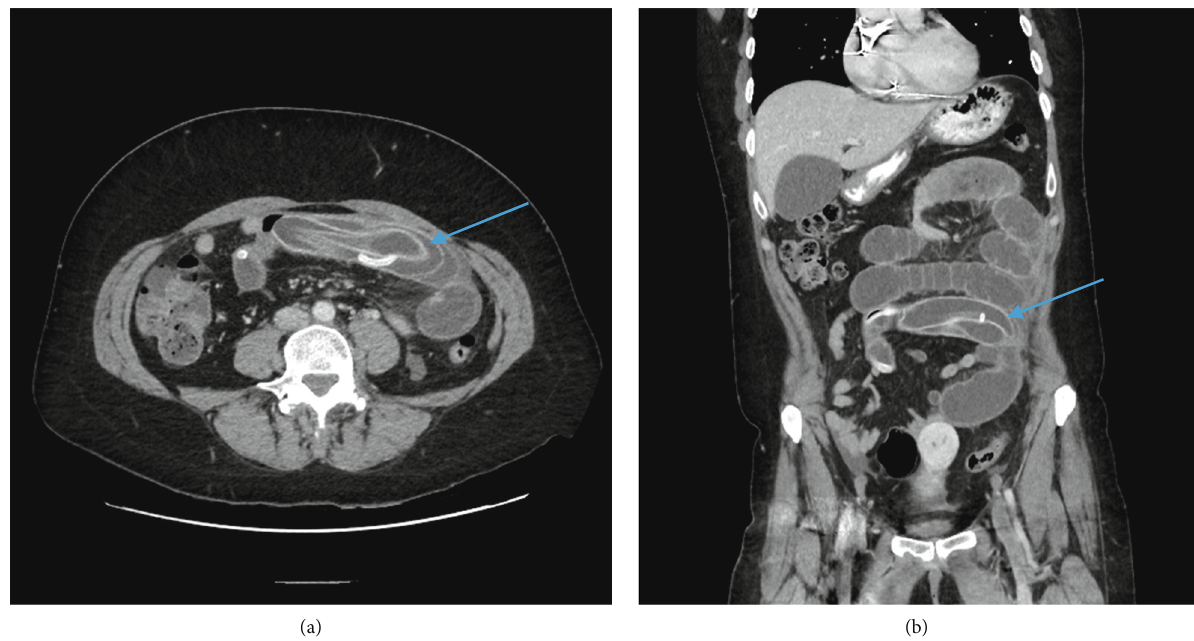
Figure 1: Computed tomography abdomen pelvis, portal venous phase showing small bowel obstruction due to migrated intragastric balloon (blue arrow). (a) Axial view. (b) Coronal view.